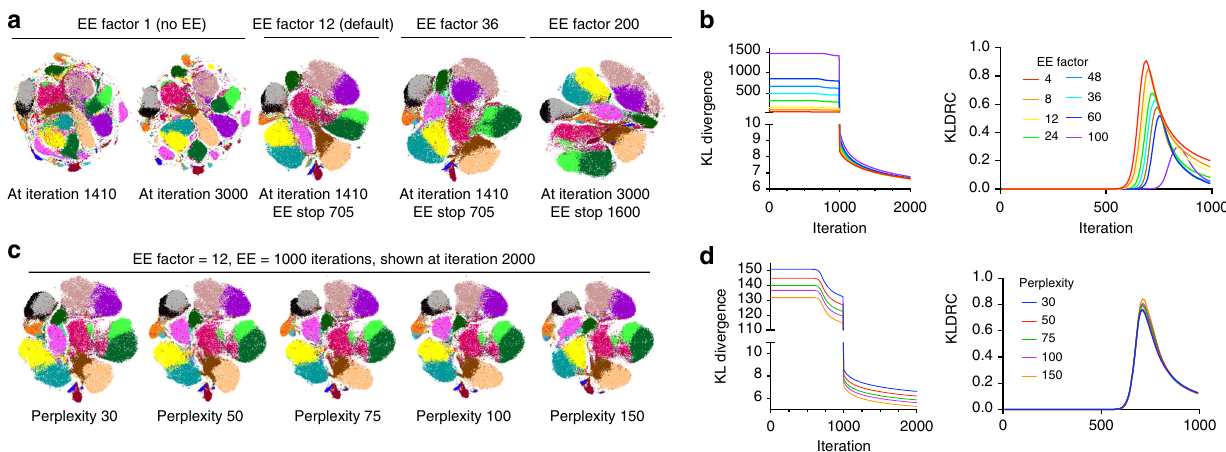
Fig. 3 Effects of perplexity and EE factor adjustments on t-SNE visualization of cytometry data. a , b KLD, KLDRC, and t-SNE biaxial plots generated with varying EE factor values. c , d KLD, KLDRC, and t-SNE biaxial plots generated with varying perplexity. Graphs showing KLD and KLDRC change over iteration time are color-labeled to distinguish curves corresponding to experiment perturbations. Color overlays on t-SNE plots correspond to cell type classes labeled as in Figs. 1, 2. Representative examples of multiple runs with varying seed values are